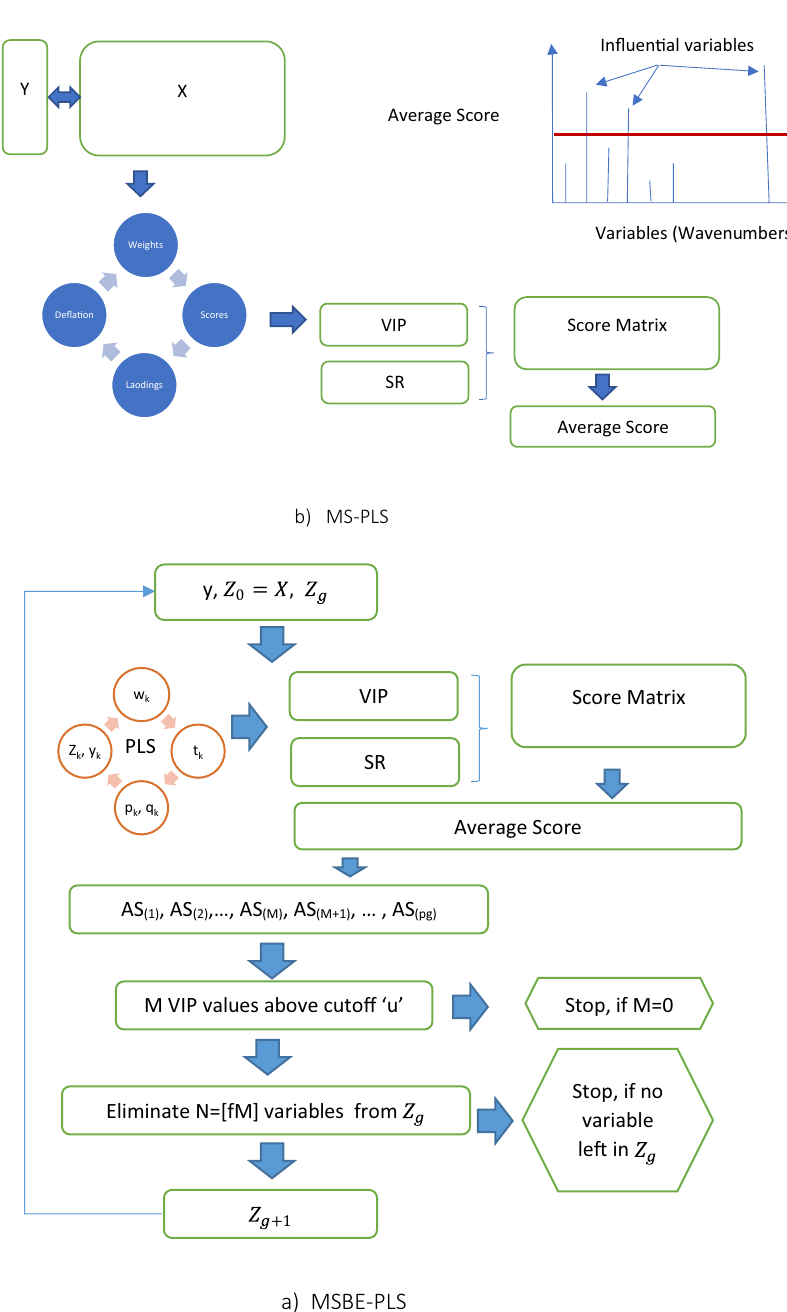
Figure 2. The computational structure of MS-PLS and MSBE-PLS is presented in upper and lower panel